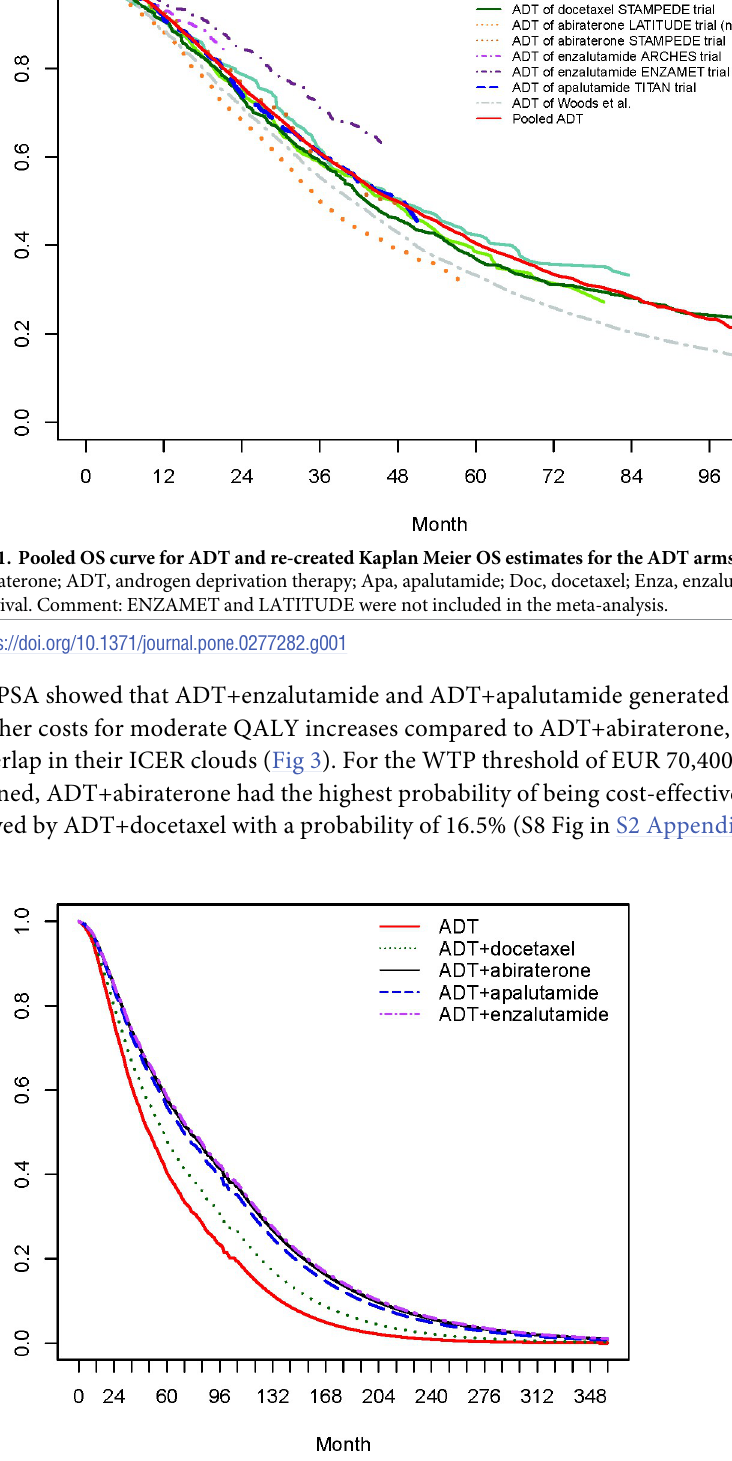
Fig 2. Estimated OS curves for ADT and intervention strategies (gamma extrapolation). ADT, androgen deprivation therapy; OS, overall